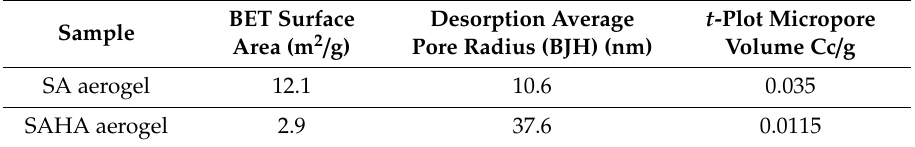
Table 1. Brunauer-Emmett-Teller (BET) surface area, pore size, and pore volume of the aerogels. Sample